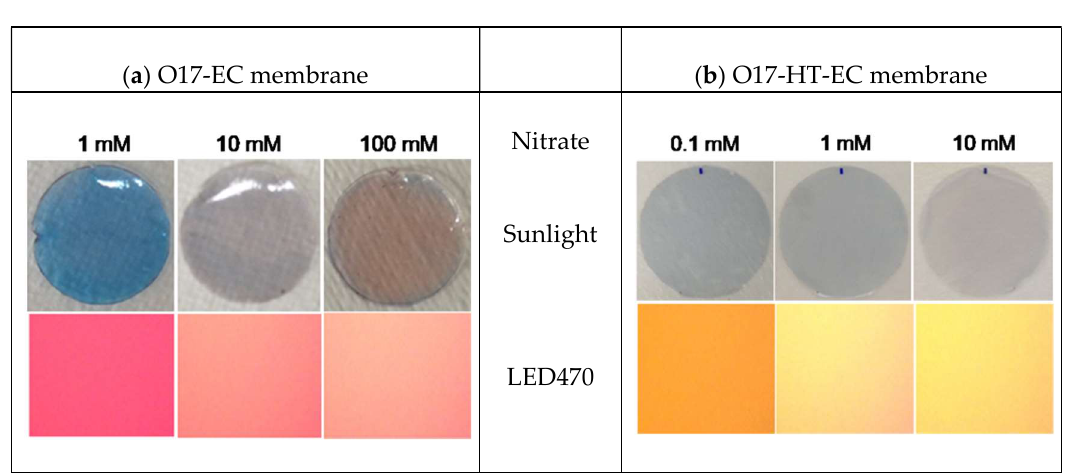
Figure 9. The visual color transitions of ( a ) the O17-EC membrane and of ( b ) the O17-HT-EC membrane when being exposed to different nitrate concentrations under sunlight (round images) or under light-emitting diode at an excitation wavelength of 470 nm (LED470) irradiation (square images).